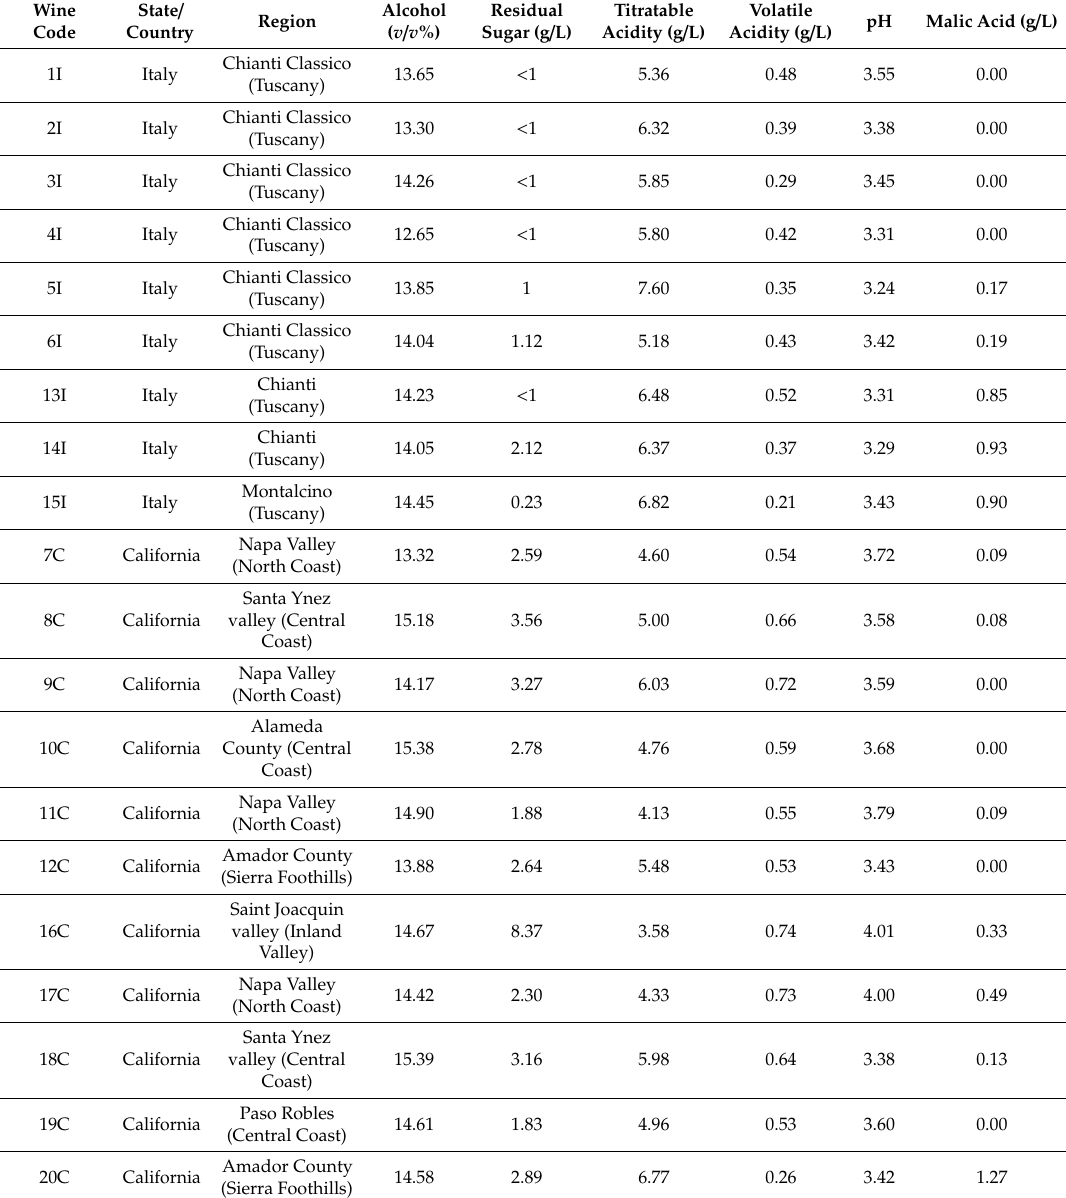
Table 1. Details of the wines in the study from California and Italy, including the region of origin and the standard chemical parameters. Only the wines 1I–6I and 7C–12C were analyzed for the sensory